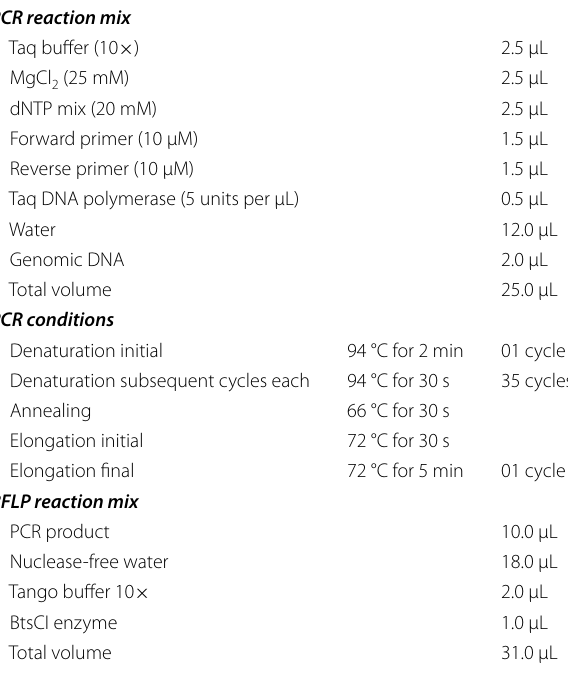
Table 1 Composition of PCR-RFLP reaction mix and PCR